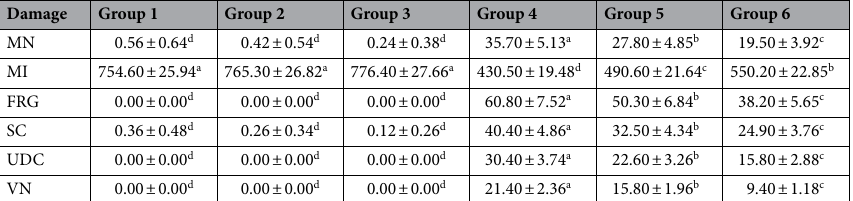
Table 3. The effect of CME against diniconazole genotoxicity. *Data are shown as mean ± SD (n = 10). Group 1: control, Group 2: 0.5 g/L CME, Group 3: 1.0 g/L CME, Group 4: 100 mg/L diniconazole, Group 5: 0.5 g/L CME + 100 mg/L diniconazole, Group 6: 1.0 g/L CME + 100 mg/L diniconazole. For MN and CAs 1,000 cells were counted in each group and 10,000 cells for MI. MN micronucleus, MI mitotic index, FRG fragments, SC sticky chromosome, UDC unequal distribution of chromatin, B bridge, VN vacuole nucleus. The averages shown with different letters (a–d) in the same line are statistically significant (p <